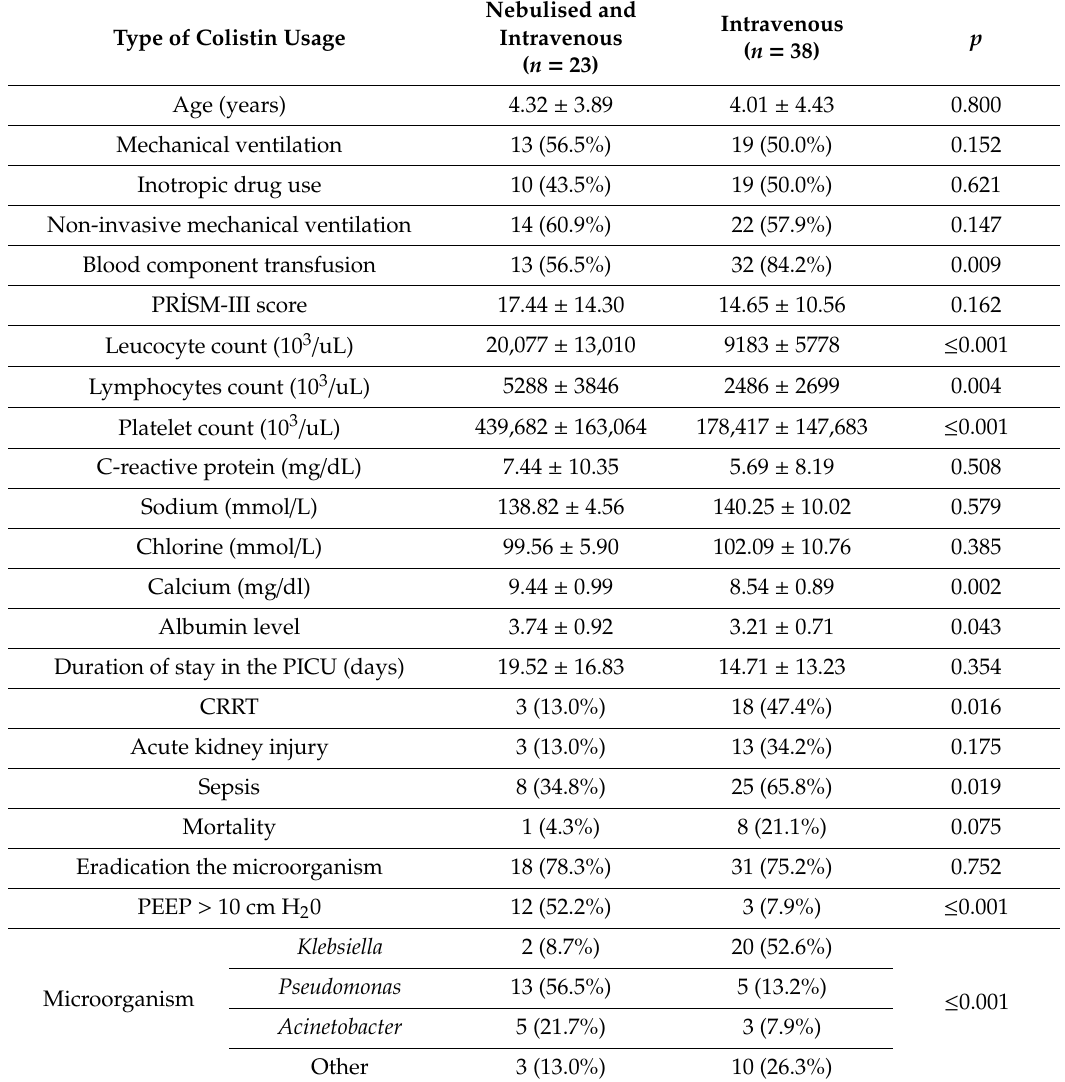
Table 4. Analysis of factors associated with adverse outcomes in nebulised and intravenous colistin